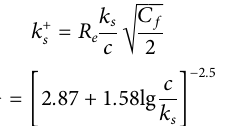
FIGURE 2 Rough blade pro fi